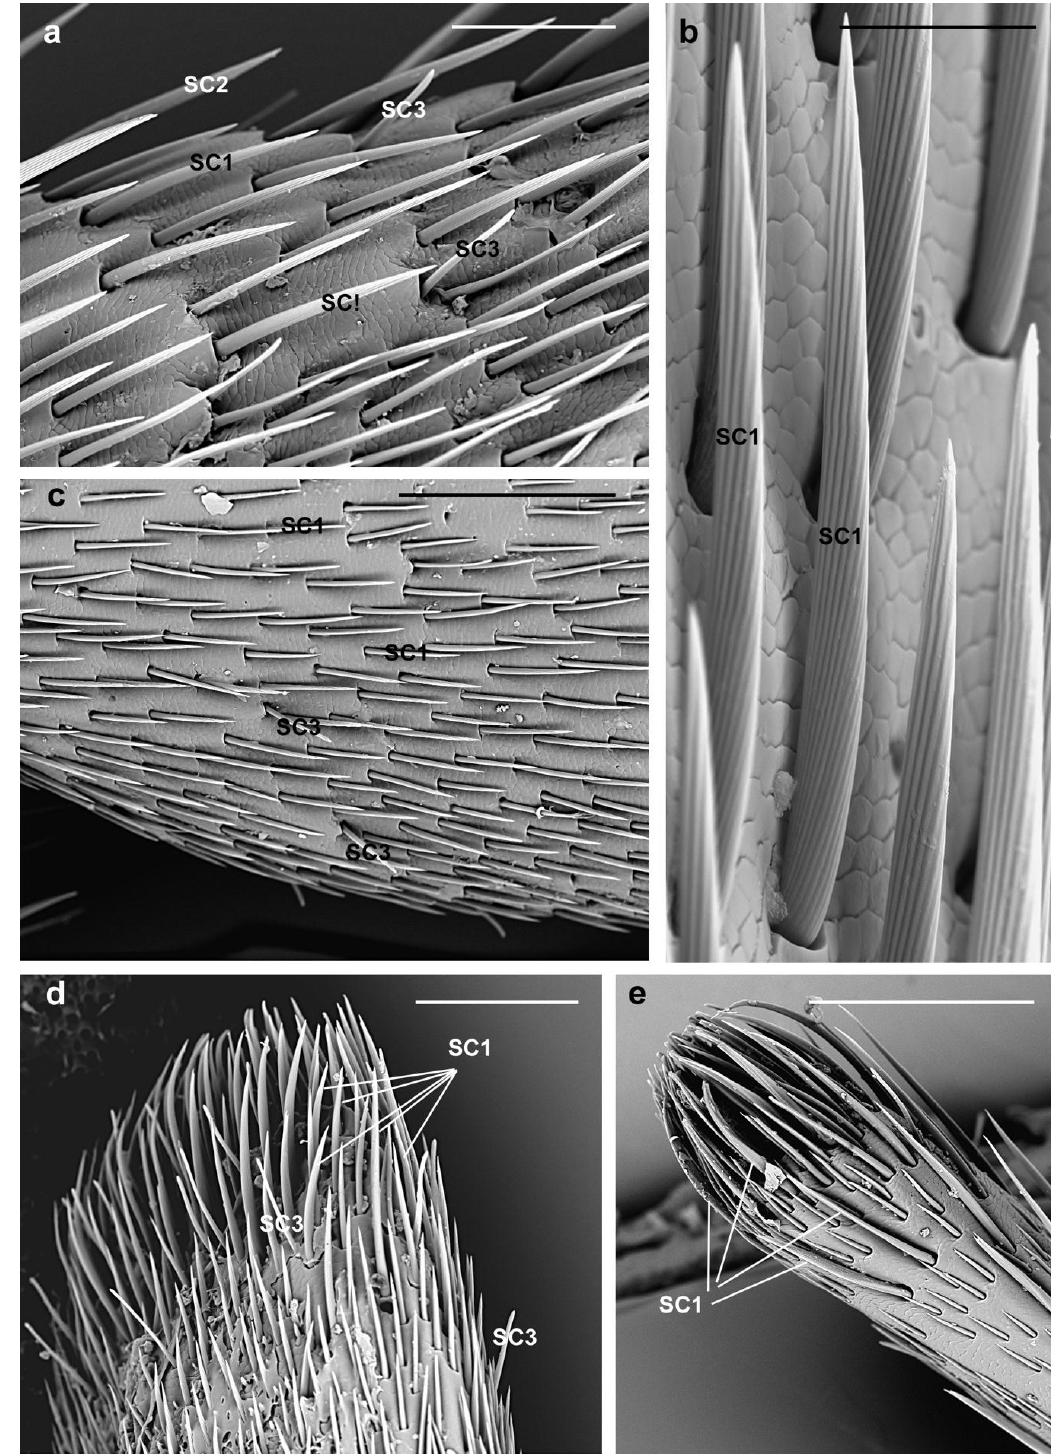
Figure 3. A. bungii , SEM. Sensilla chaetica SC1. ( a ) Overview of SC1 on the female second flagellomere. ( b ) Detail of the V-shaped grooved pattern on the shaft surface and the sharp tip. ( c ) View of the even distribution around the circumference of the female antennomeres. SC1 on the tip of ninth flagellomere in female ( d ) and male ( e ). Abbreviations: SC1, sensillum chaeticum type 1; SC2, sensillum chaeticum type 2; SC3, sensillum chaeticum type 3. Scale bars: 100 µm ( a , d , e ); 30 µm ( b ); and 200 µm (C).